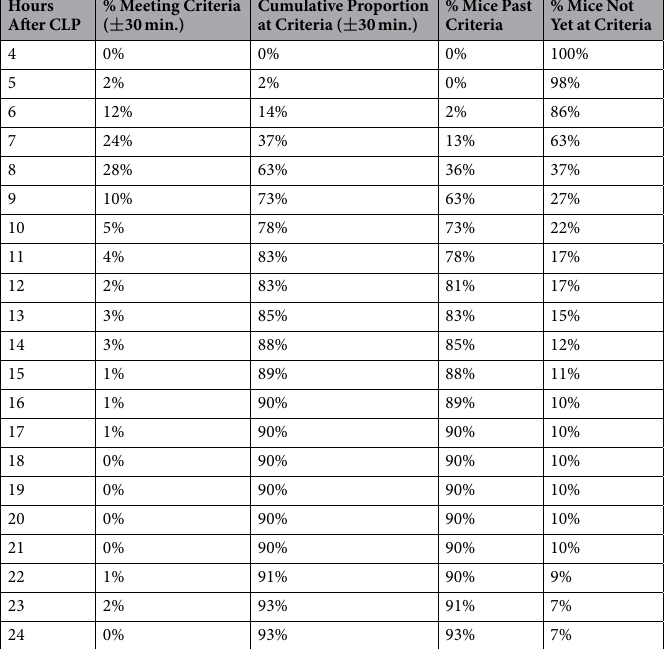
Table 1. Proportions of mouse at each physiologic state after cecal ligation and puncture. Proportions of mice at, beyond, or before criteria for acute physiologic deterioration are presented each hour after cecal ligation and puncture.